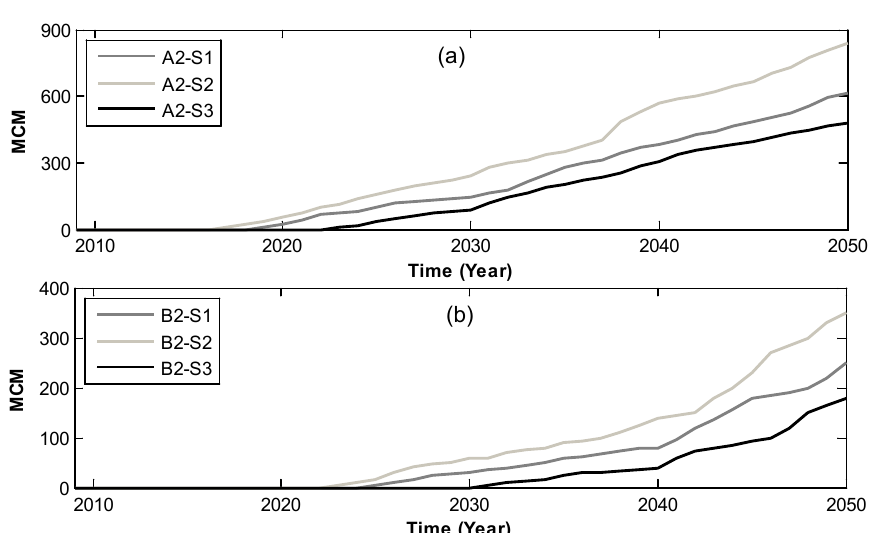
Fig. 6 Unmet demand for three adaptation strategies (S1, S2 and S3) based on the A2 and B2 scenarios using WEAP